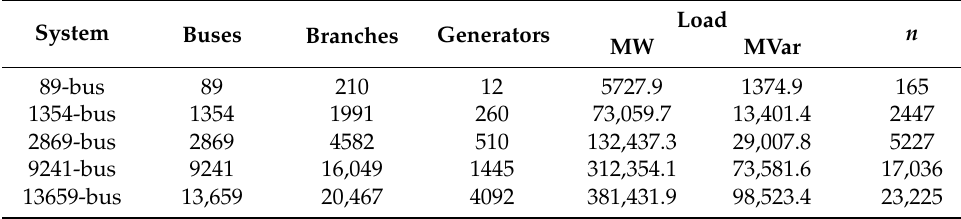
Table 2. Main characteristics of the studied